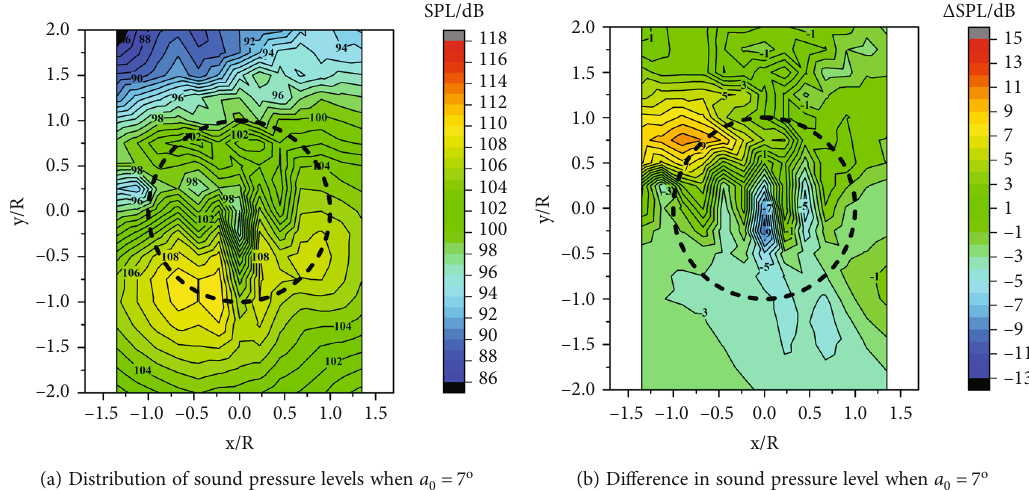
Figure 17: Distribution of SPL below the ECR under Scheme C and their di ff erence from the sound level in the reference state.